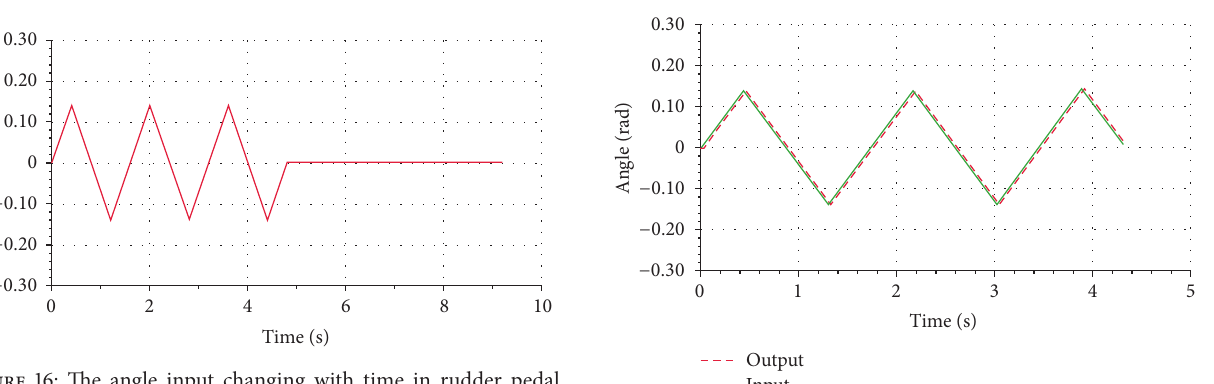
Figure 16: The angle input changing with time in rudder pedal operation mode.